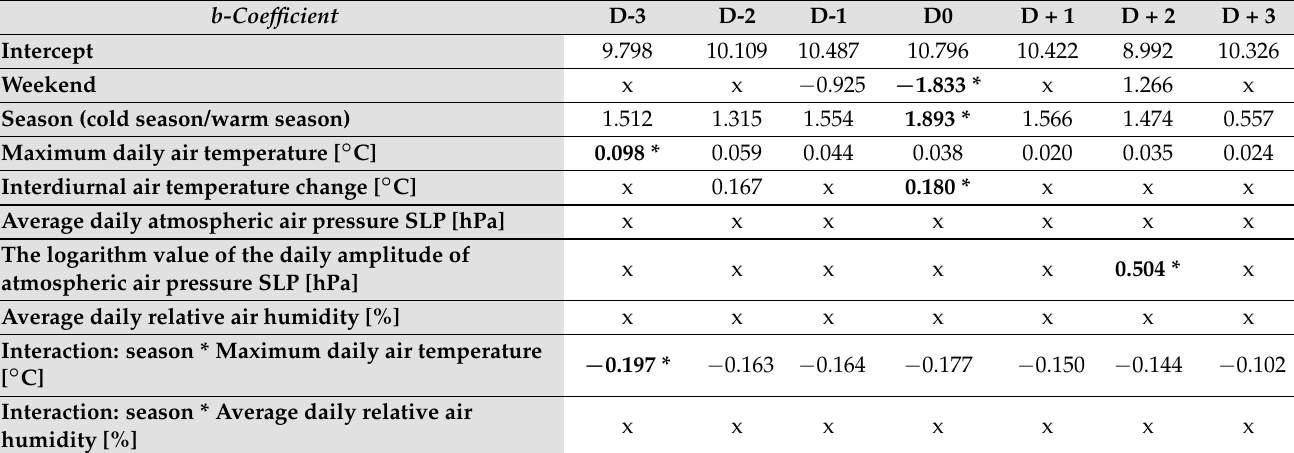
Table 5. Values of slope coefficients in seven regression models obtained by stepwise removal of